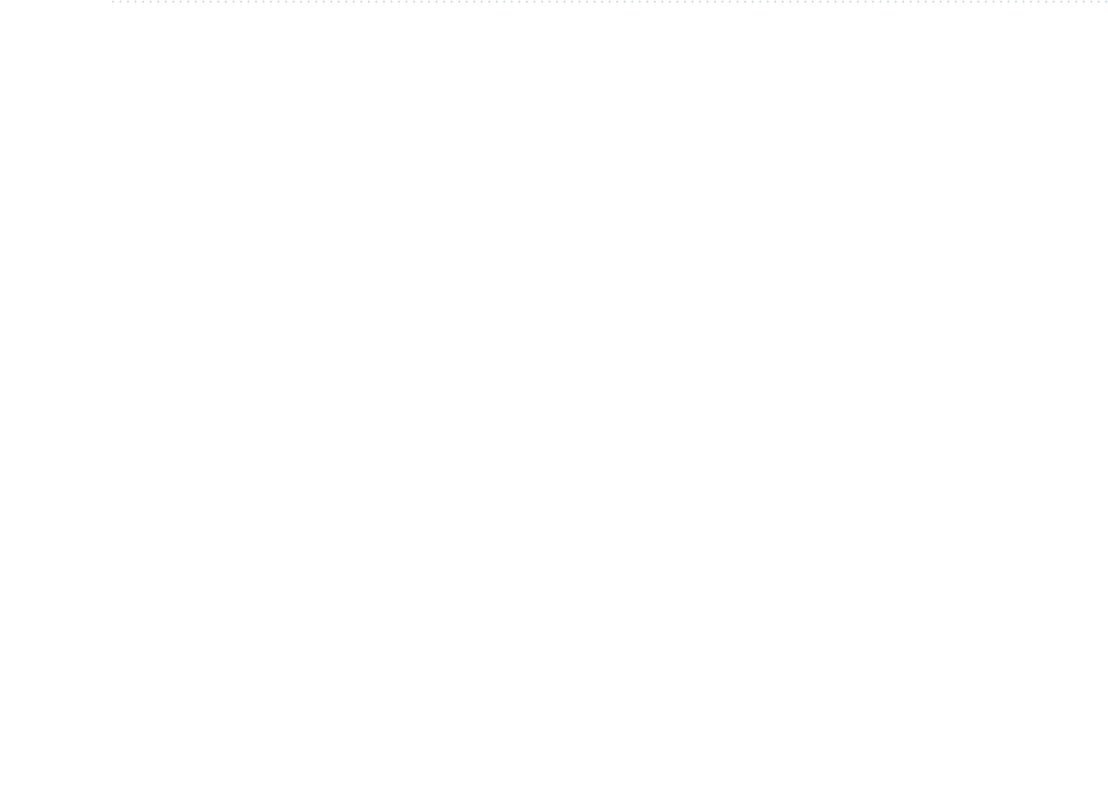
Figure 10. ( a–d ) Represent the PR curves on Imagenet-100 of all methods with different bits. (Created by “matlab R2019a” url: https:// ww2. mathw orks. cn/ produ cts/ matlab.